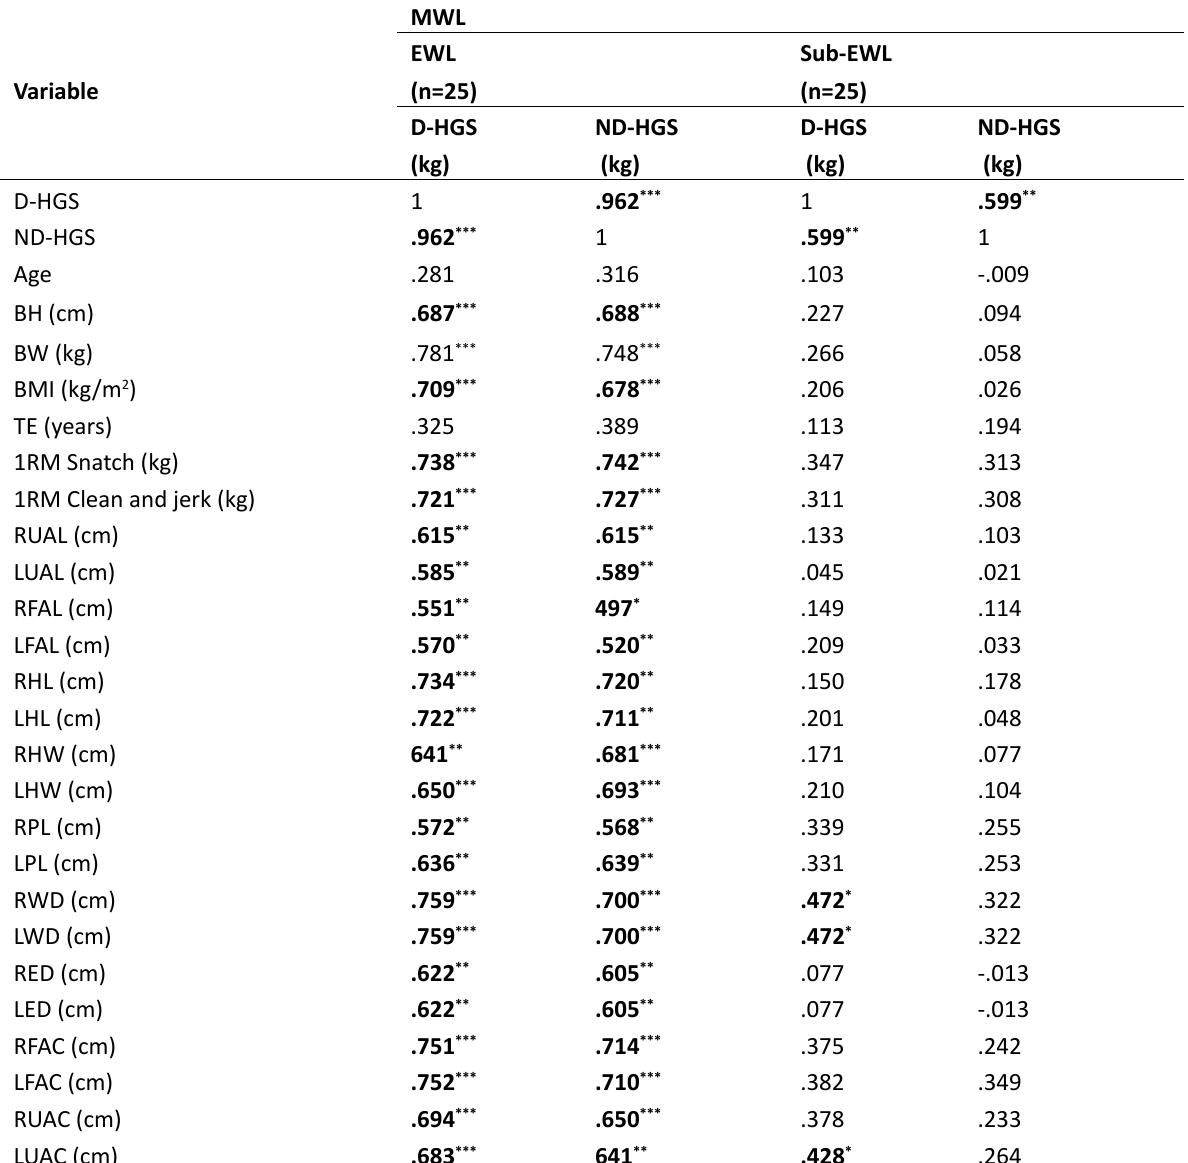
Table 4. The correlation between HGS values and other variables: anthropometric characteristics, TE, weightlifting performance of